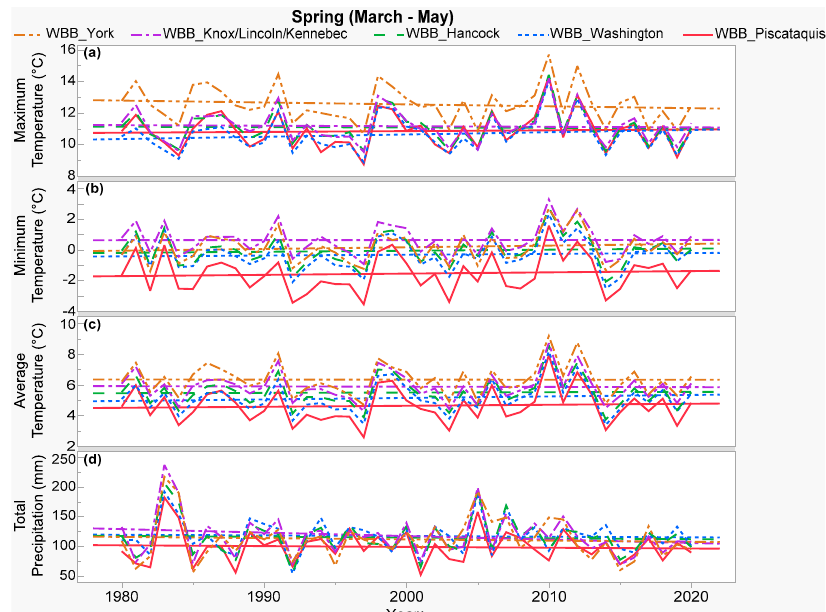
Figure 11. Comparison of historical (1980 to 2020) spring climate parameters: ( a ) maximum temperature, ( b ) minimum temperature, ( c ) average temperature, and ( d ) total precipitation among the studied wild blueberry barrens (WBBs) in different counties from north-central (Piscataquis) and north-east (Washington, Hancock) to south-west (Knox, Lincoln, Kennebec, York) of Maine as shown in Figure 1.